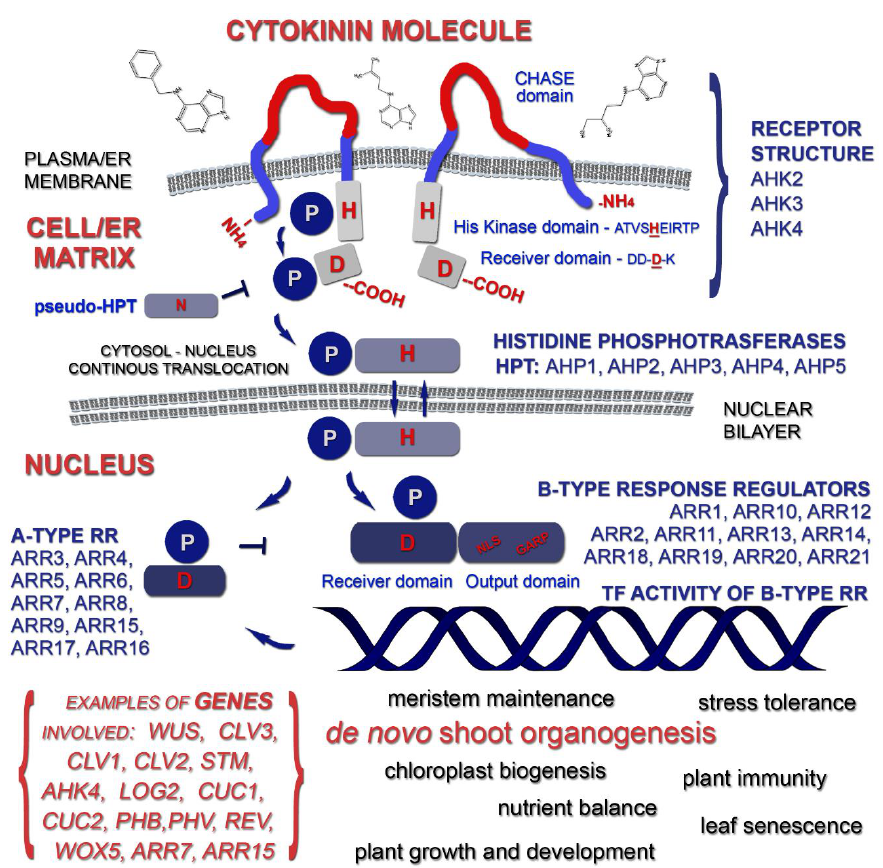
Figure 2. Cytokinin signal transduction in plants.